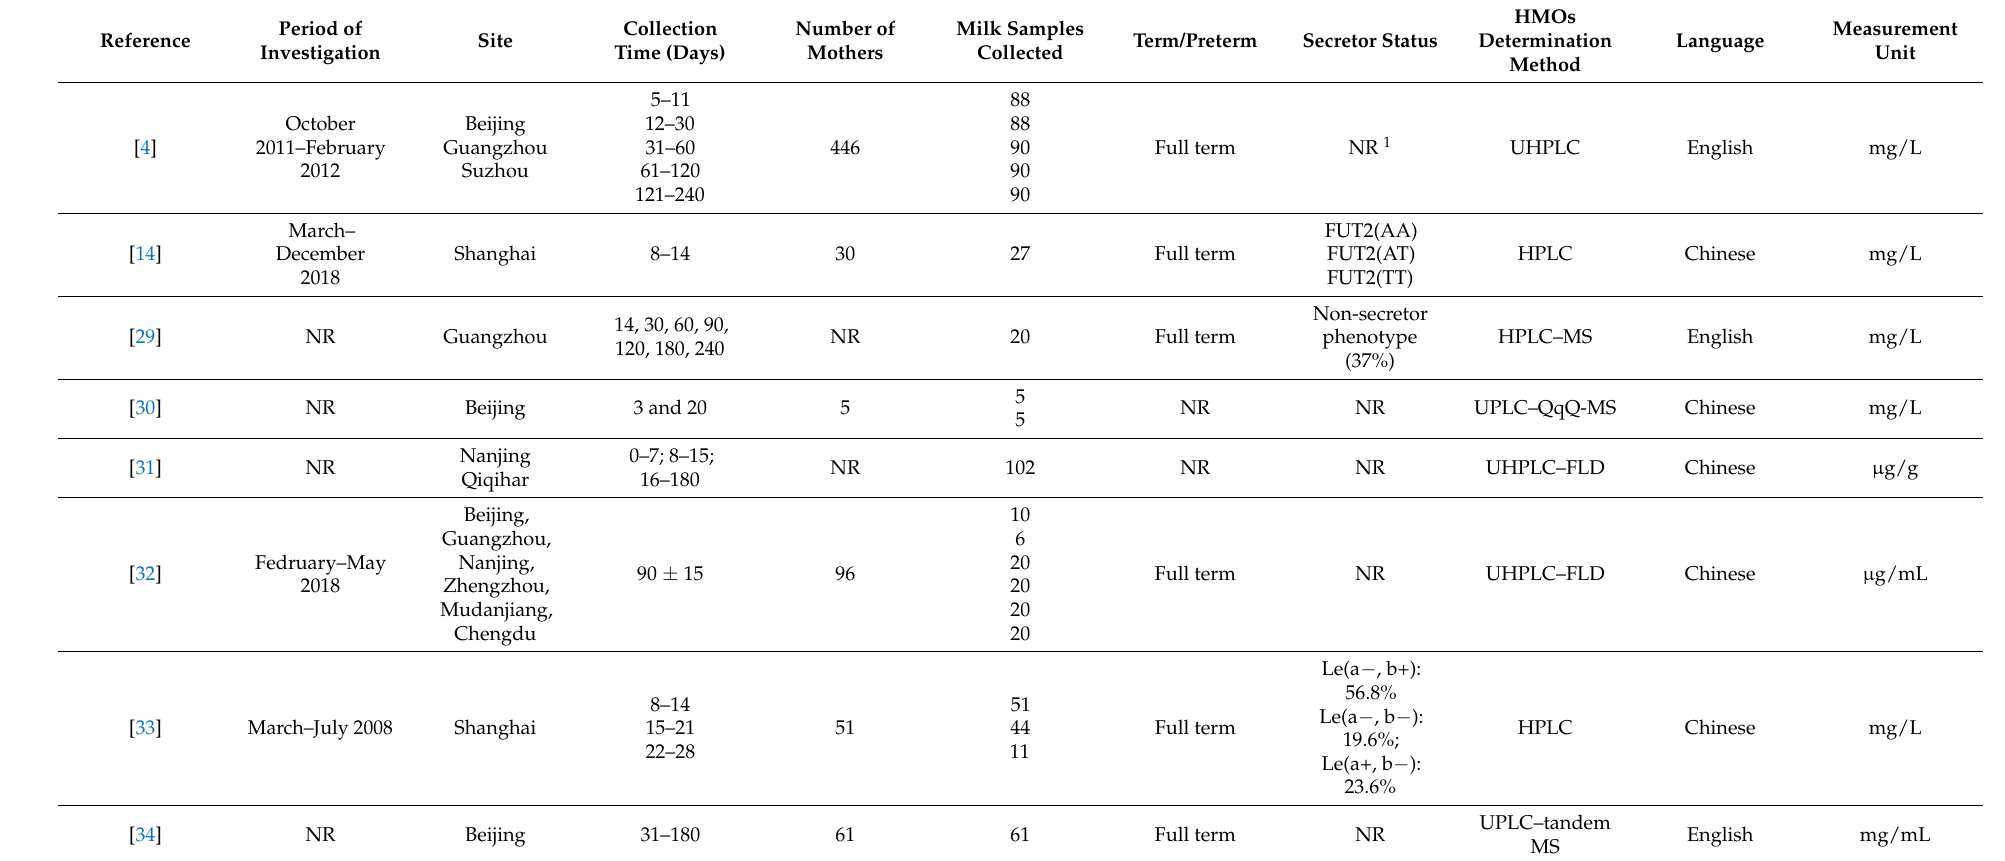
Table 1. Inclusion and exclusion criteria for article